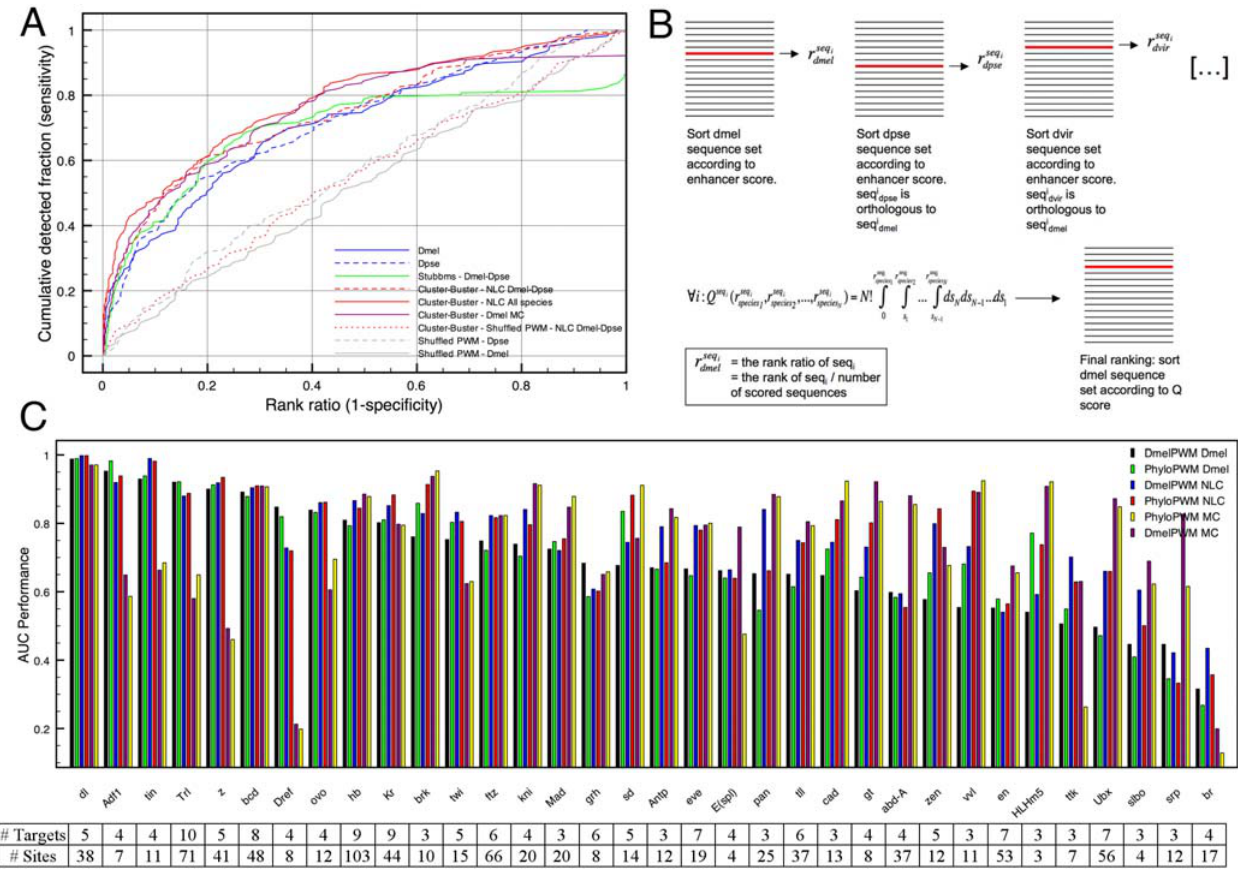
Figure 3. Integrating HMM-based enhancer scoring across multiple genomes. (A) LOOCV performances of Cluster-Buster (red dashed curve) and STUBBMS (green curve) on two genomes ( Dmel and Dpse ), Cluster-Buster on all genomes using network-level conservation (NLC) (red curve), and Cluster-Buster combined with motif conservation (MC) (purple curve). The red dotted curve is the negative control. (B) Implementation of network- level conservation by integrating the Cluster-Buster scores on multiple genomes through order statistics. Rank ratios for orthologous sequences (both positive and negative) are obtained for each species separately and are integrated by the order statistics formula. Dmel sequences are finally ranked according to the integrated score. (C) LOOCV performances (AUC values in the y axis) for each TF (x axis), using the Dmel PWM or the phyloPWM. The first two bars represent the scoring on Dmel alone, the next two on all genomes with network-level conservation (NLC), and the last two on all genomes with motif conservation (MC). The TFs are sorted according to decreasing baseline performance (black).